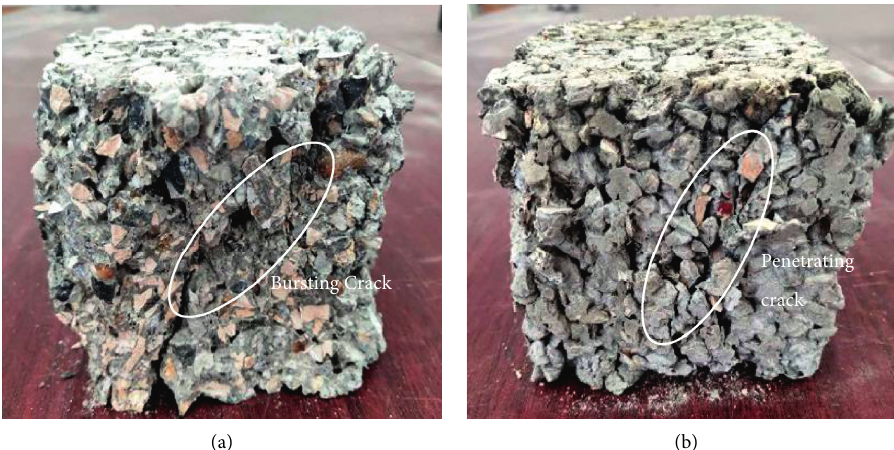
Figure 9: Macroscopic damage pattern of RCCAPC and fiber-reinforced RCCAPC after compressive test. (a) RCCA